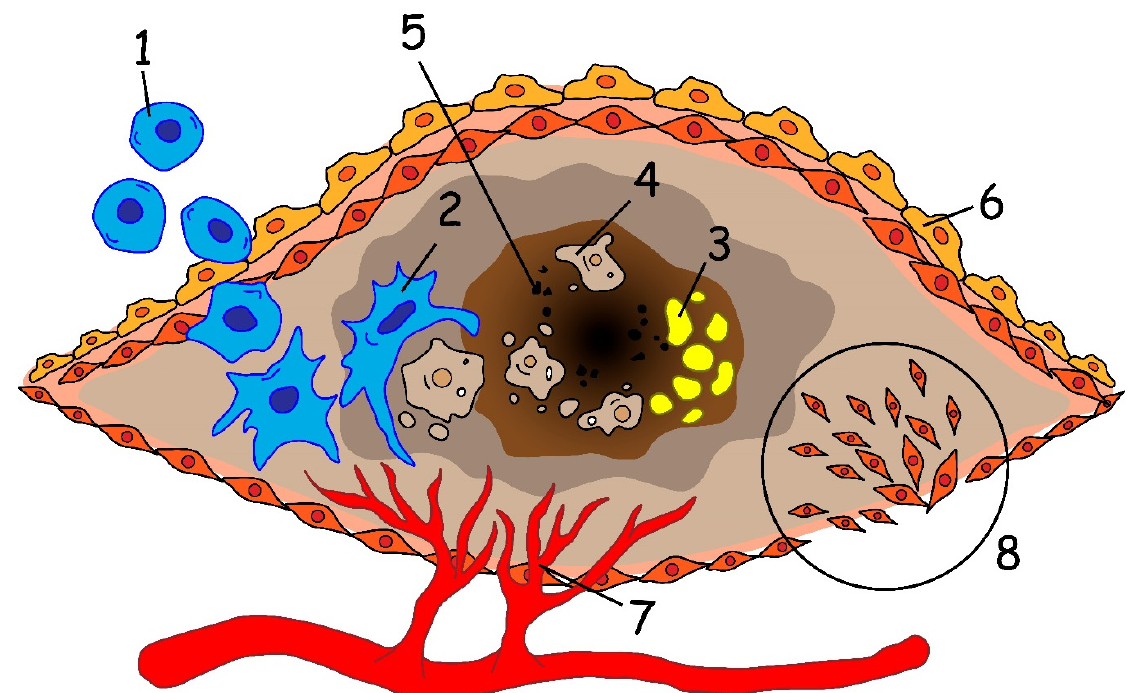
Figure 1. The main routes of atherosclerosis development and plaque growth. ( 1 ) Monocytes are being recruited to a developing plaque, transforming ( 2 ) to macrophages. Macrophages accumulate in plaque, absorb ( 3 ) lipids and become ( 4 ) foam cells. Apoptosis and necrosis of foam cells, as well as deficient efferocytosis, lead to the formation of ( 5 ) necrotic core inside the vessel wall. ( 6 ) Endothelium cells produce different pro-inflammatory factors that promote the accumulation of macrophages. Extensive plaque ( 7 ) neovascularization leads to intraplaque hemorrhages. Migration of ( 8 ) VSMCs promotes neointima growth and restenosis after grafts installation.